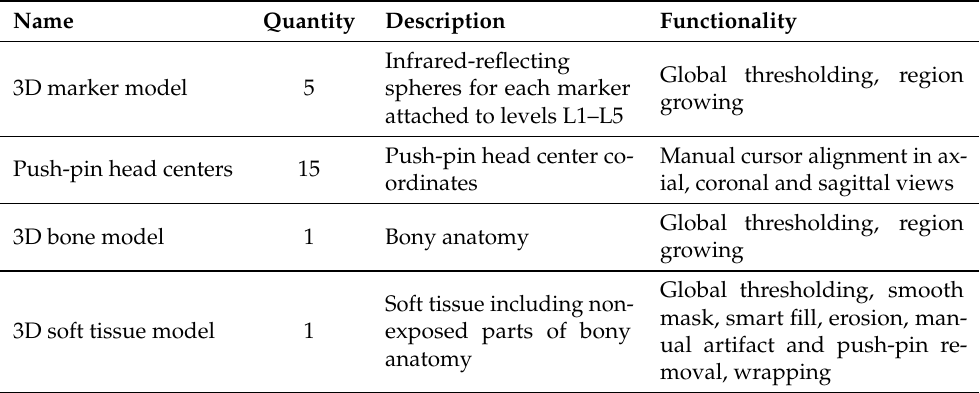
Table 1. Extracted data from postoperative CT for each specimen and used